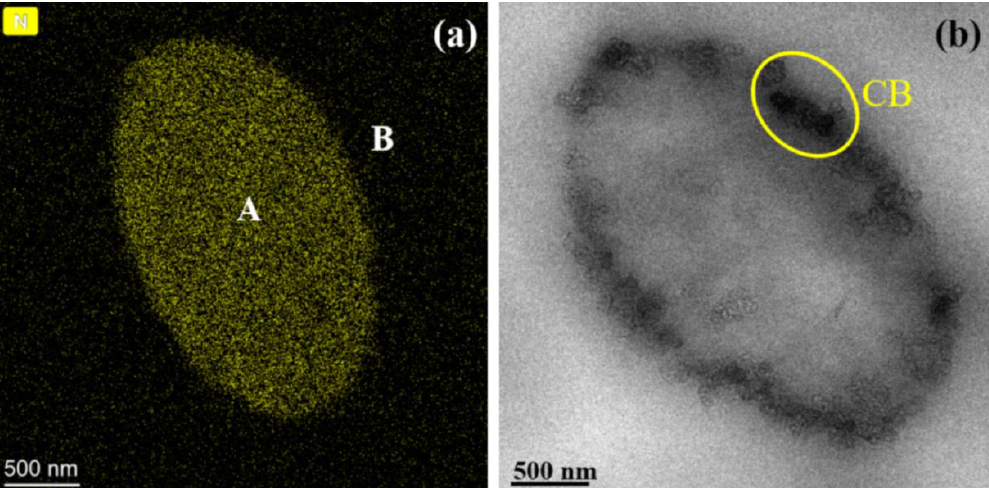
Figure 3. ( a ) EDS mapping image of the elements N (yellow) and ( b ) TEM micrograph of the cross-section of individual PA6 microfibrils surrounded with the PP matrix.